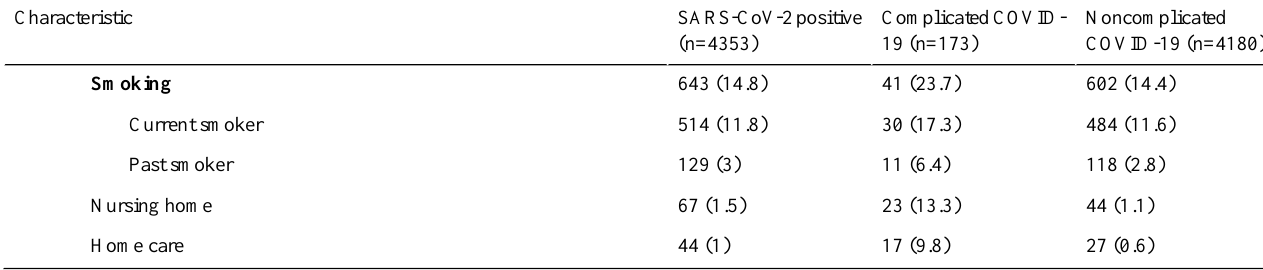
Table 2. Association of male sex and coronavirus disease (COVID-19) complications across age groups. FemaleMale NoncomplicatedComplicatedNoncomplicatedComplicated